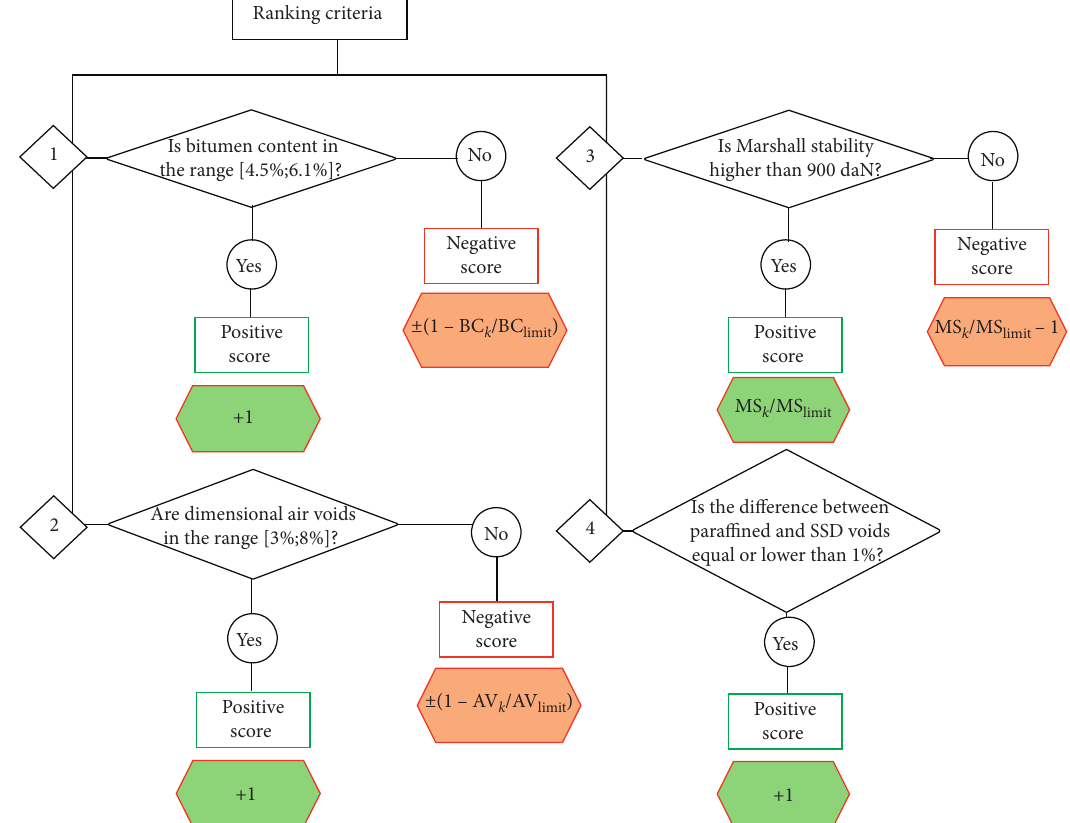
Figure 13: Flow diagram of the ranking procedure and ranking